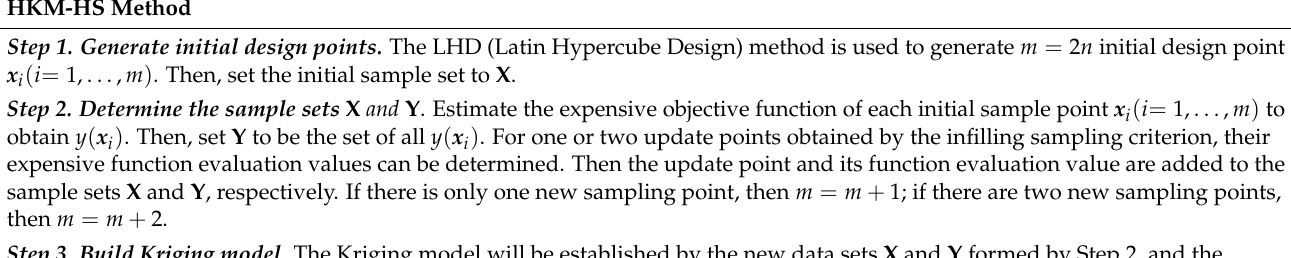
Table 2. The specific steps of high-precision Kriging modeling method based on hybrid sampling criteria (HKM-HS). HKM-HS Method